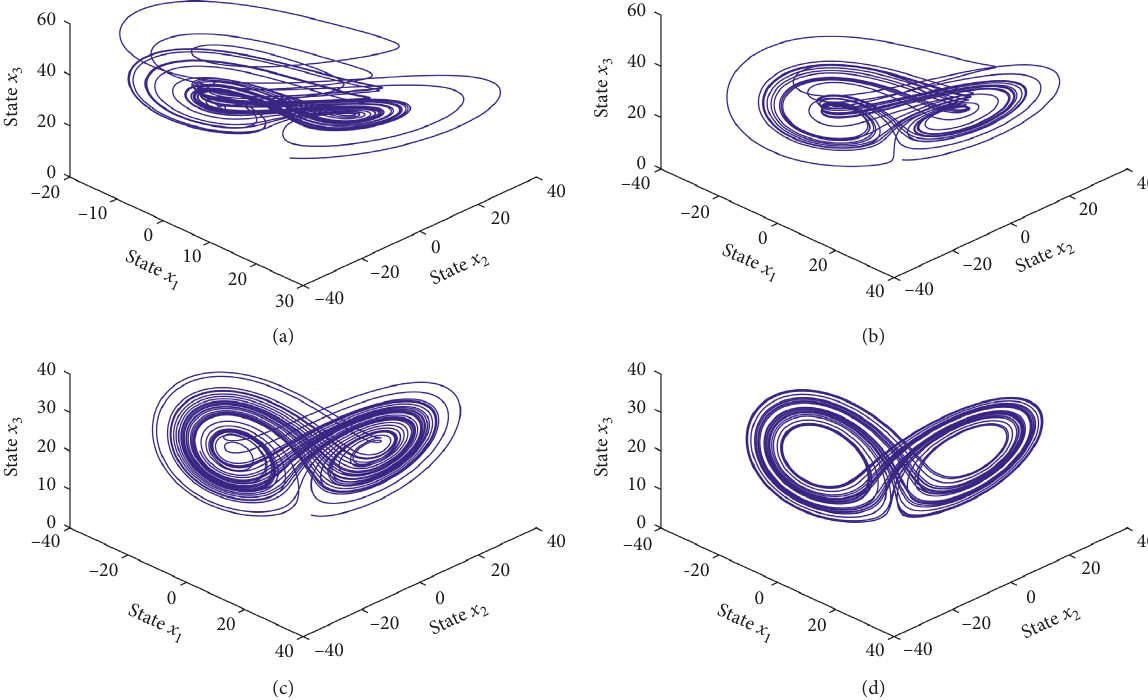
Figure 3: The attractor of the tempered fractional Chen system with different λ